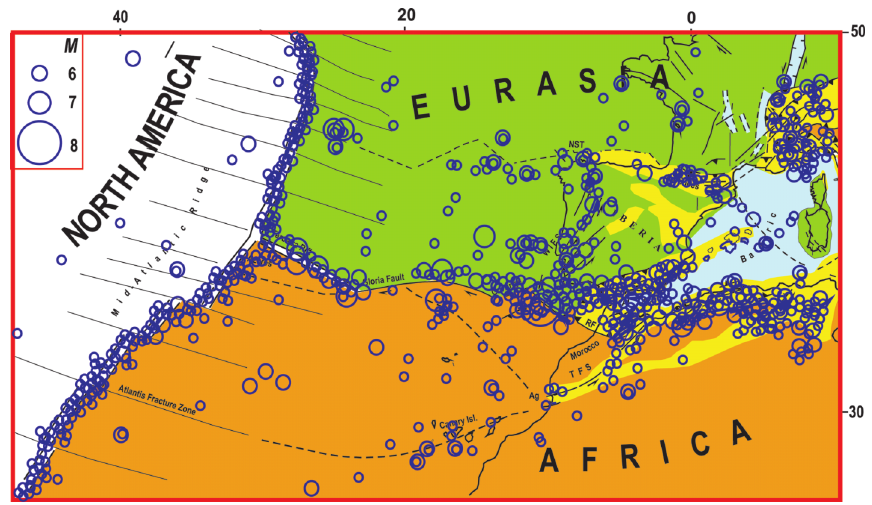
Fig. 2. Seismicity distribution in the Western Mediterranean-Atlantic region ( M > 4.5, 1964-2006) from the database of the Incorporated Researcher Institutions for Seismology (IRIS), available at <http://www.iris.washington.edu>. NST=North Spanish Trench; TFS=Transmoroccan Fault